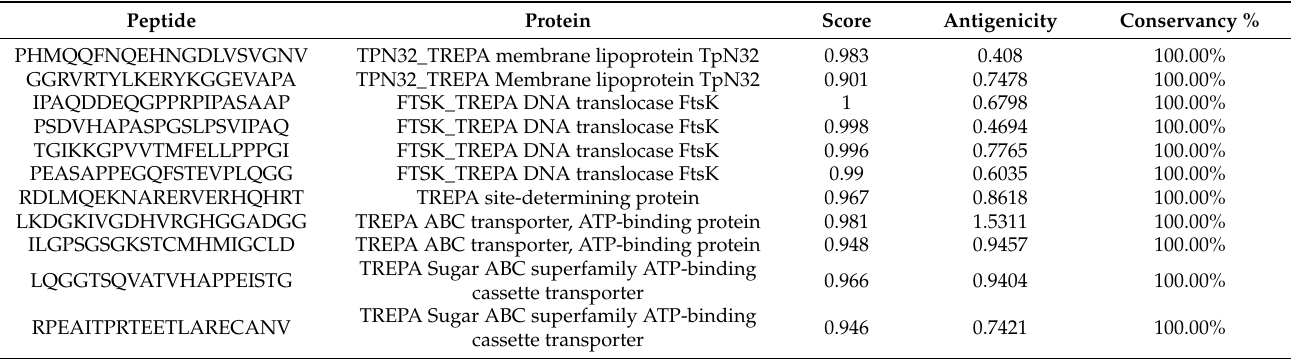
Table 4. Predicted linear B-cell epitopes.